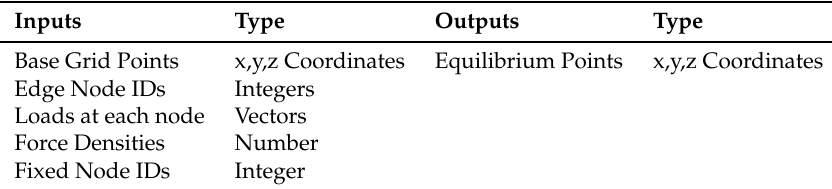
Table 2. Force Density Method (FDM) inputs and outputs.